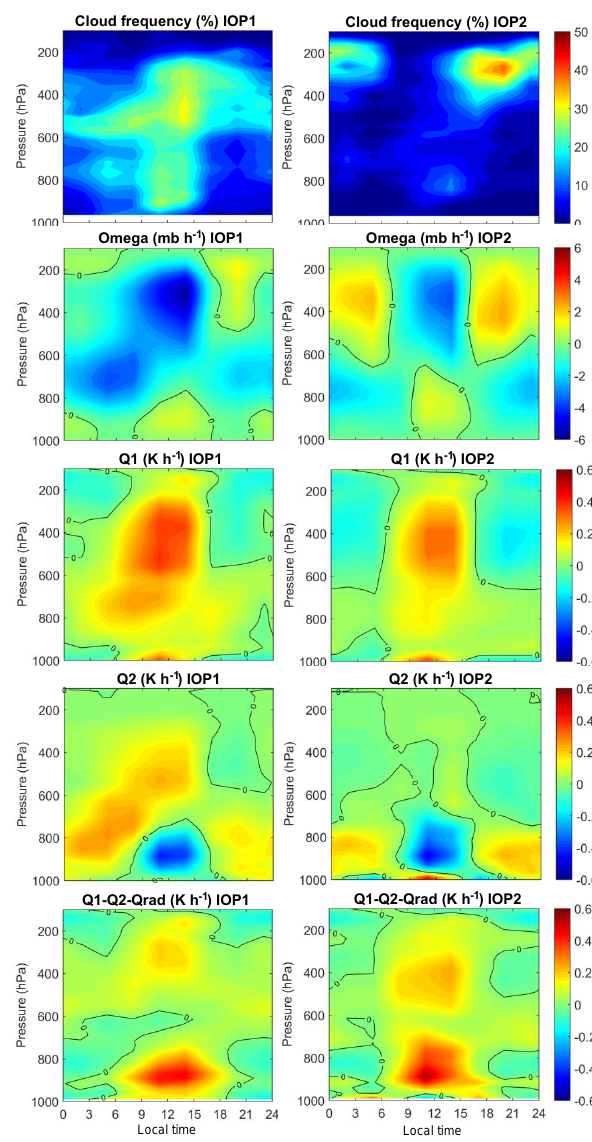
Figure 8. The diurnal cycle of (from top to bottom) cloud frequency, large-scale vertical velocity, Q 1 , Q 2 and Q 1 − Q 2 − Q rad for IOP1 and IOP2. The black lines are